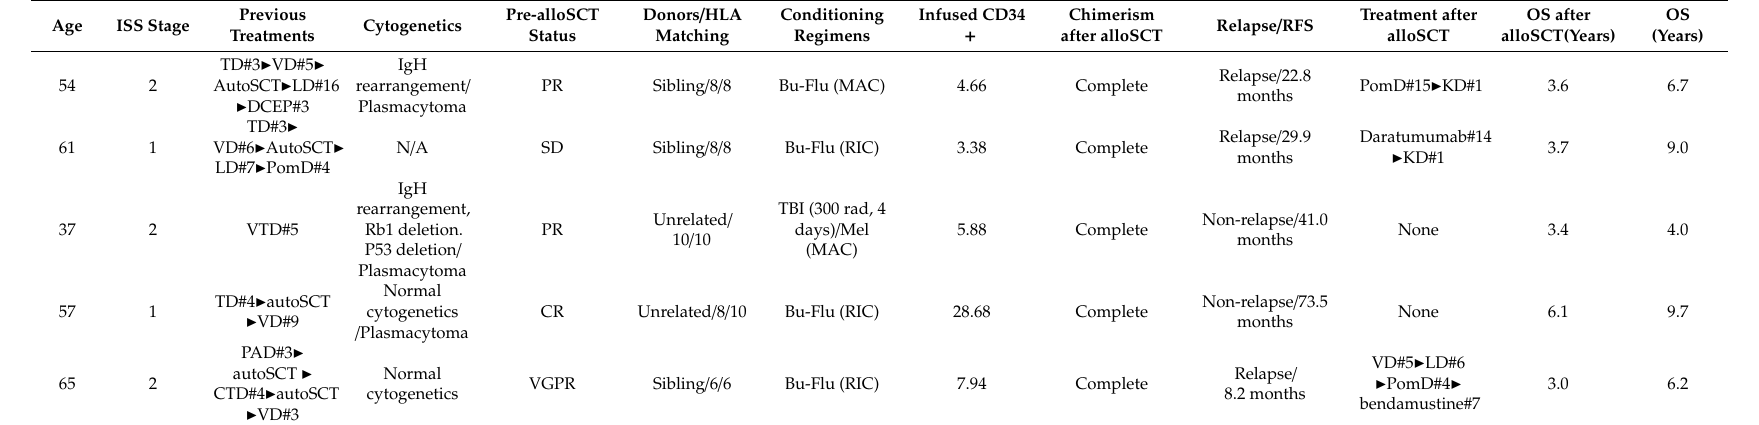
Table 4. Long term survival